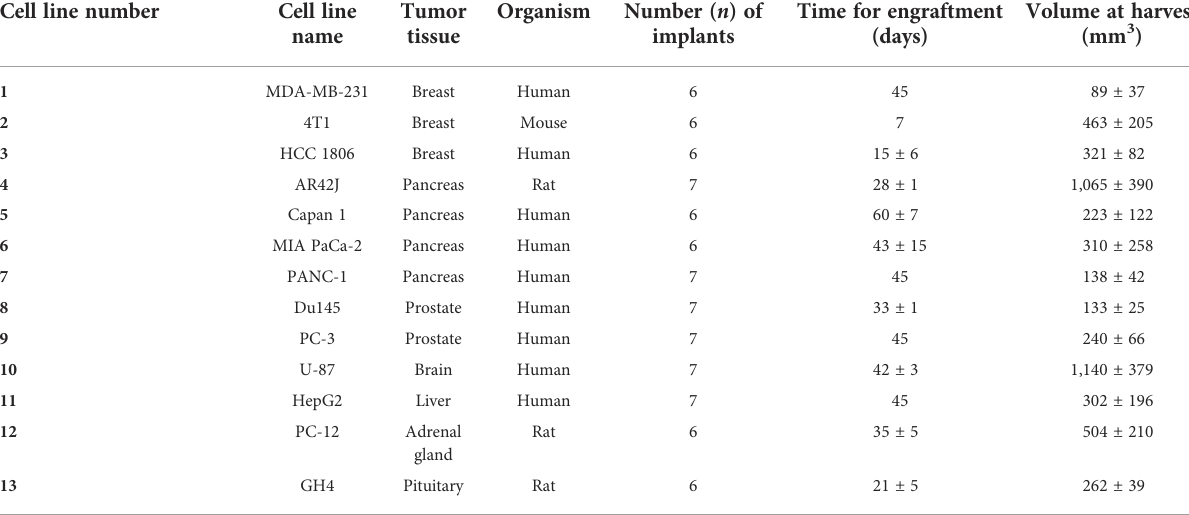
TABLE 1 Tumor cell lines, origin, and provided